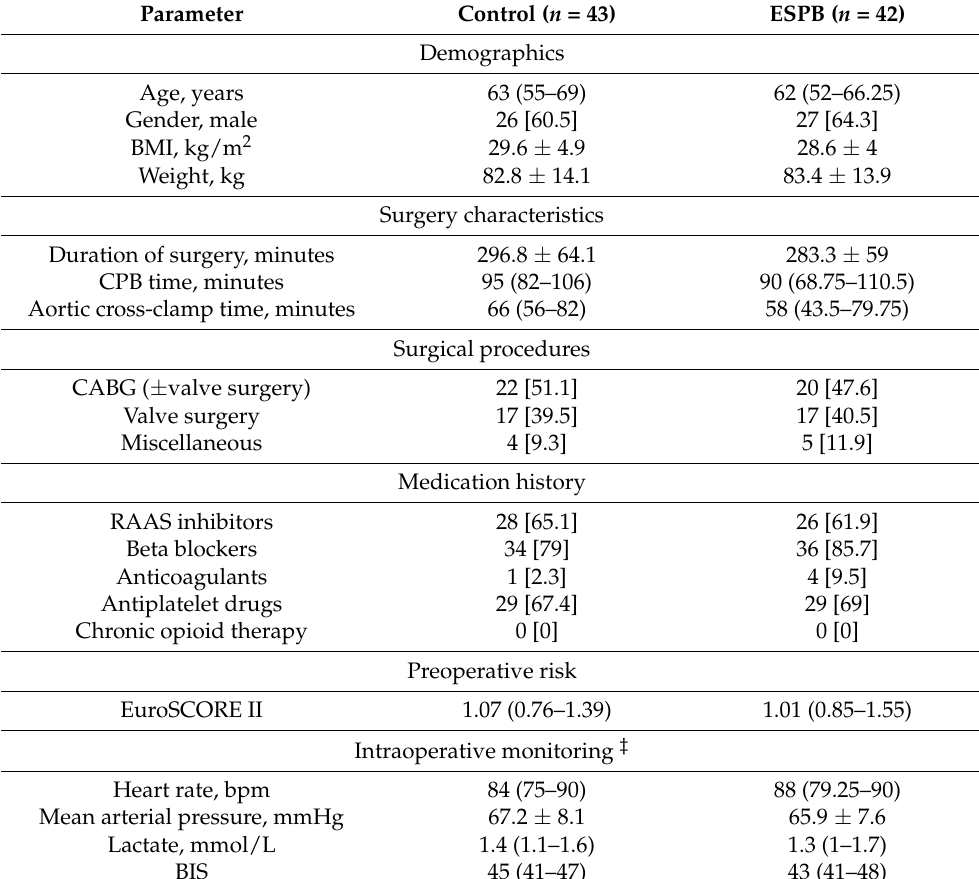
Table 1. Baseline and perioperative patient